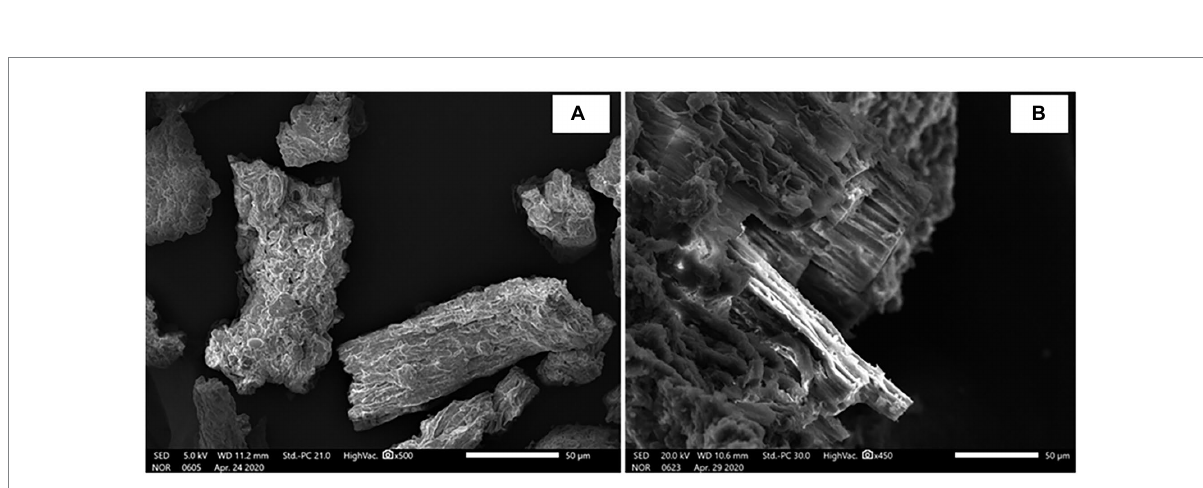
FIGURE 7 SEM images of BC examples from different samples. All scale bars represent 50 μ m. (A) represents BC from biomass burning particles (BBP); (B) represents wood